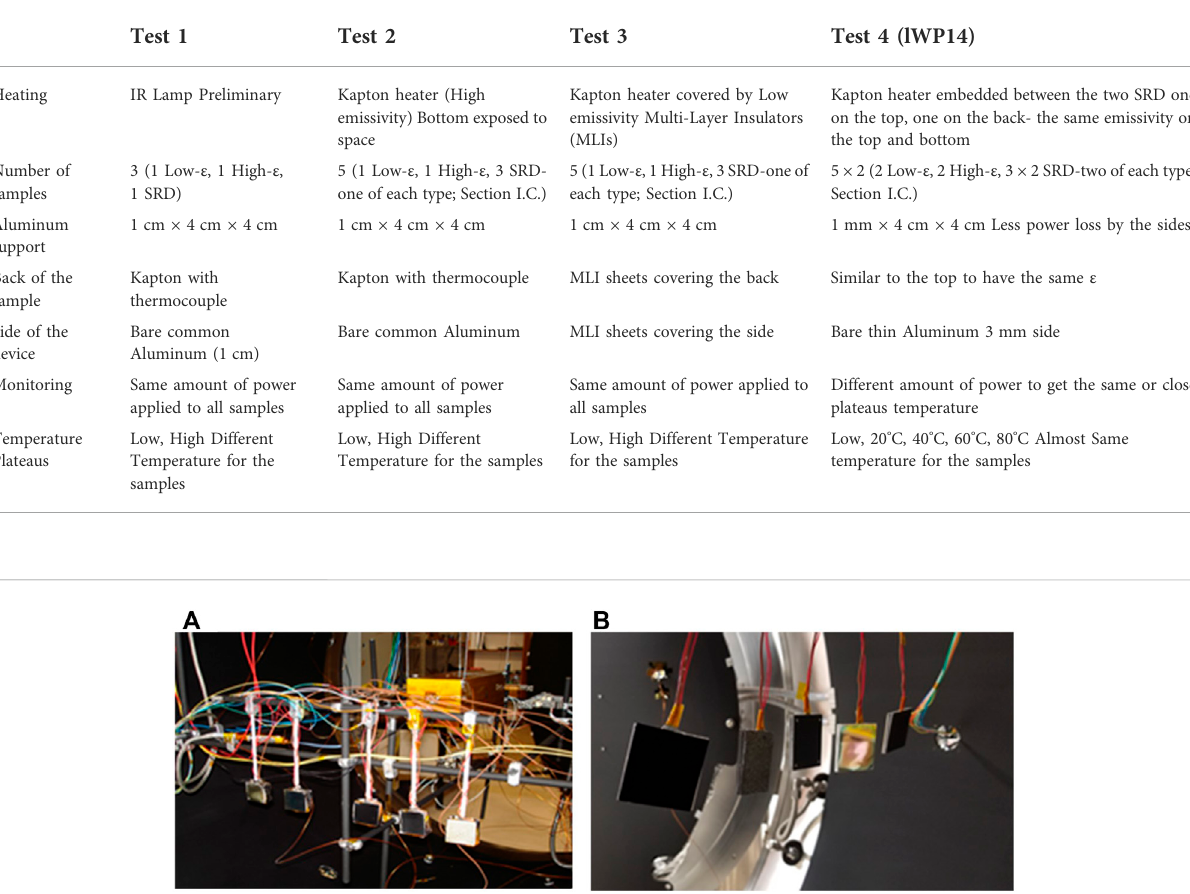
TABLE 3 Comparison of the four TVAC tests, the improvement is in bold.